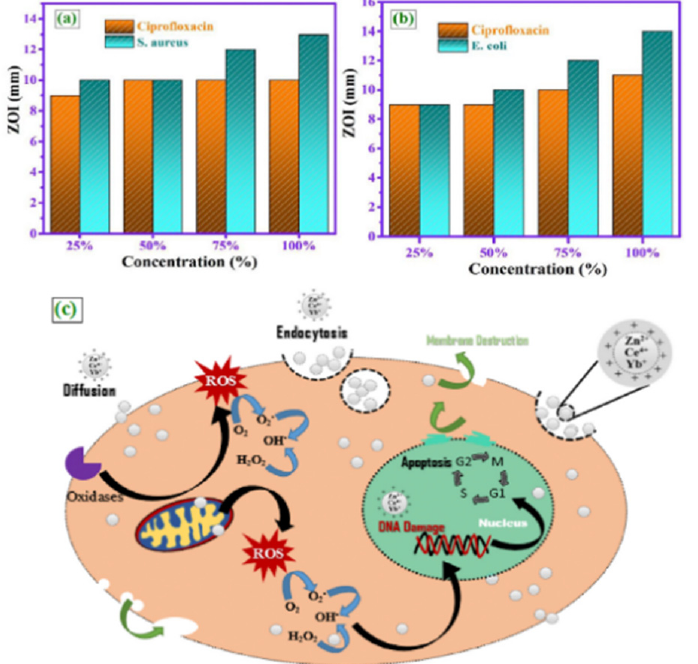
Figure 21. Comparison of the zone of inhibition (ZOI) against different species of bacteria ( a , b ), mechanism of antibacterial activity of ZnO–CeO 2 -Yb 2 O 3 nanocomposite ( c ). Reprinted/adapted with permission from Ref. [203]. Copyright© 2022, Elsevier Masson SAS.